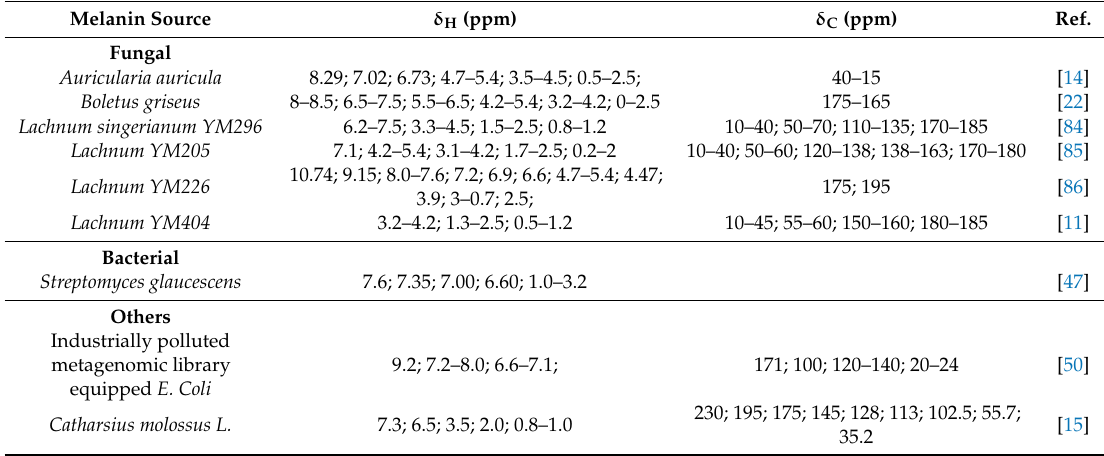
Table 8. The 1 H and 13 C-NMR chemical shifts reported for di ff erent melanins. Melanin